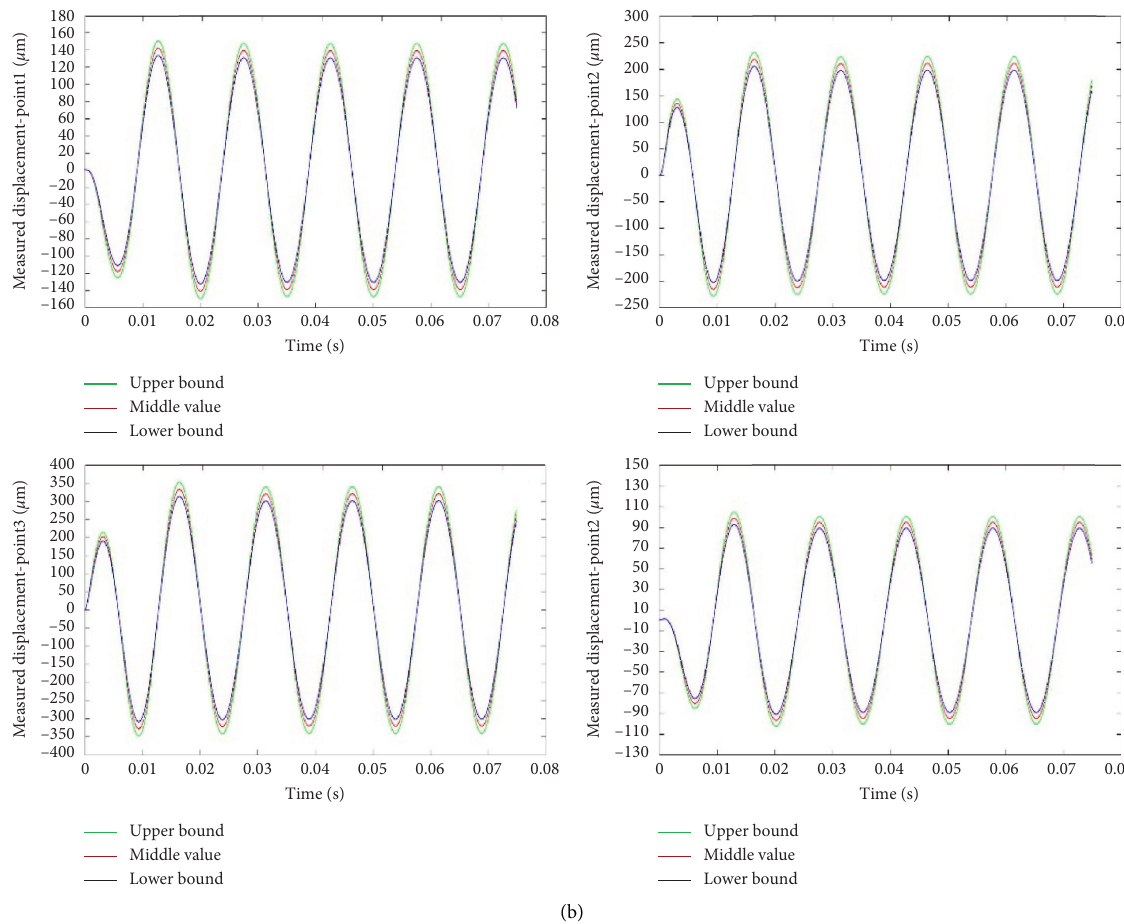
Figure 5: The rotor structure transient response: (a) the sensitivity curve of the transient response to the interval parameters; (b) the bounds of the rotor structure transient